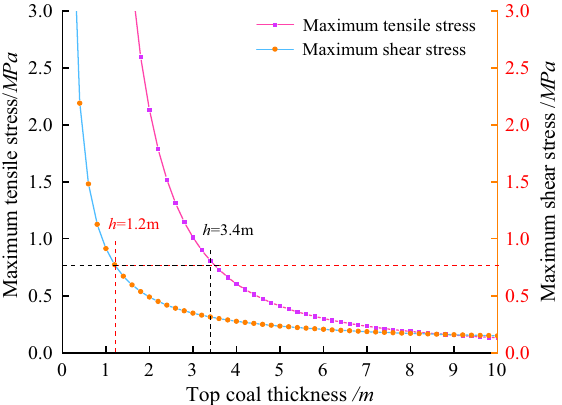
Figure 6. Variation of maximum tensile and shear stress with top coal thickness.